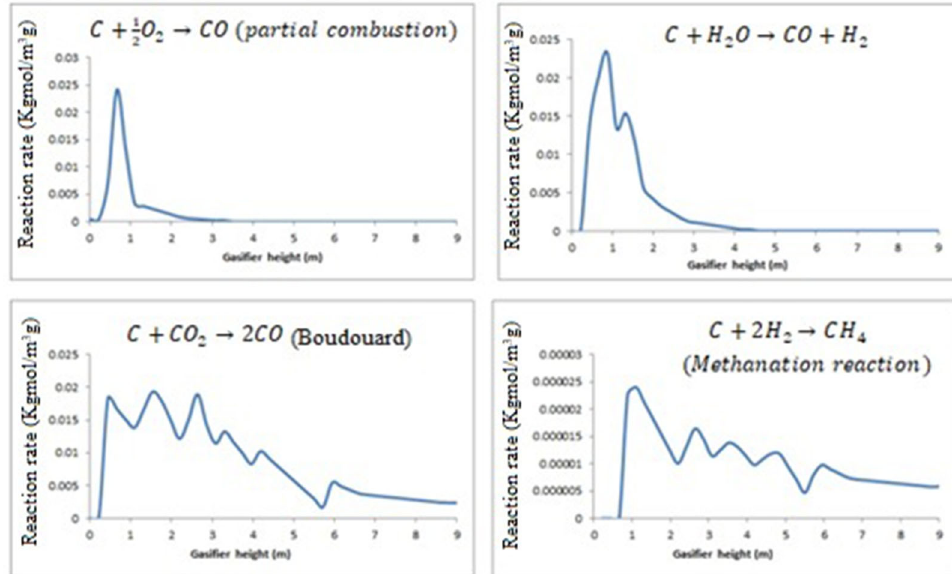
Fig. 10 Heterogeneous reaction rates along gasifier height